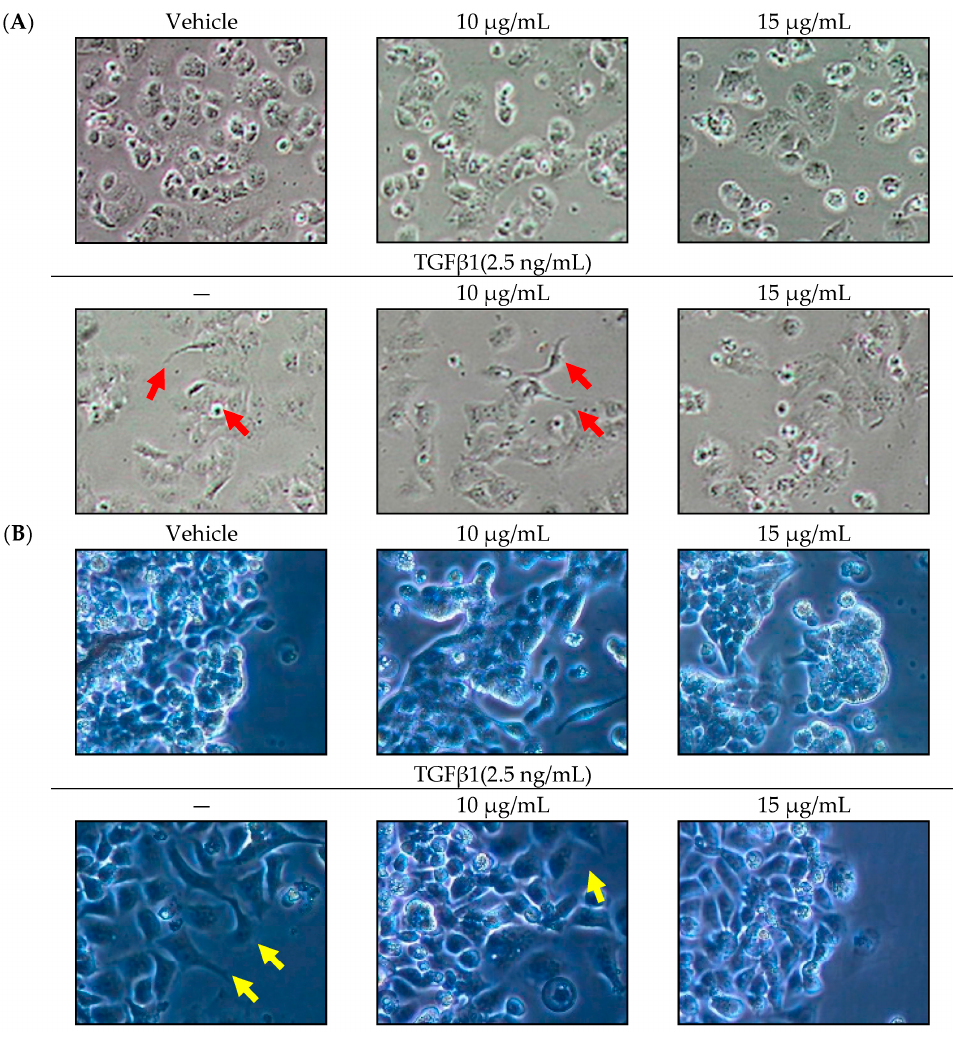
Figure 1. Changes of morphology of endometrial cancer cells in absence or presence of SOE for 24 h of incubation. ( A ) HEC-1A cells and ( B ) RL95-2 cells. Photomicrographs of culture plates were directly obtained under a phase-contrast microscope (Nikon Eclipse TS100, Chiyoda-ku, Tokyo, Japan; magnification 20×). Arrow indicates lamellipodia-like structure.